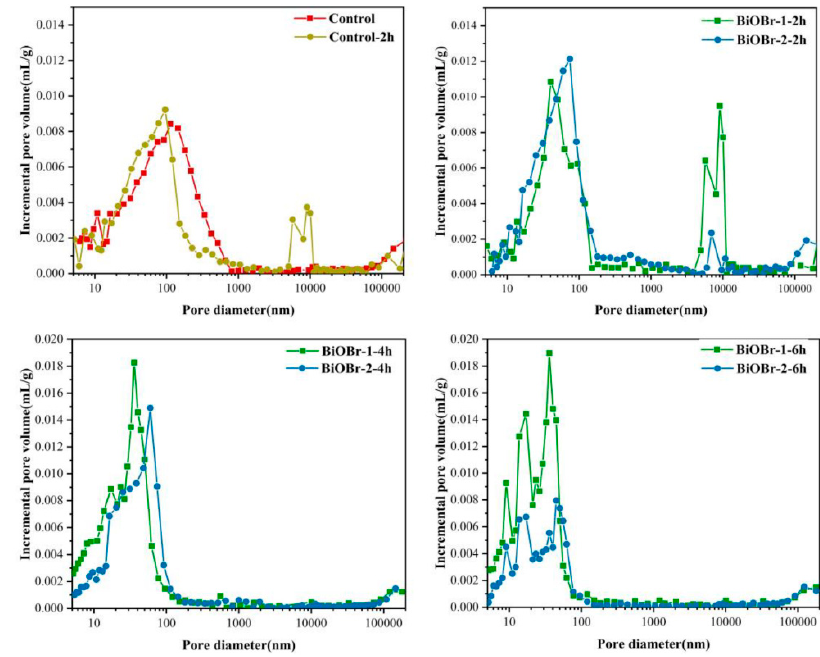
Figure 5. Differential pore size distributions of